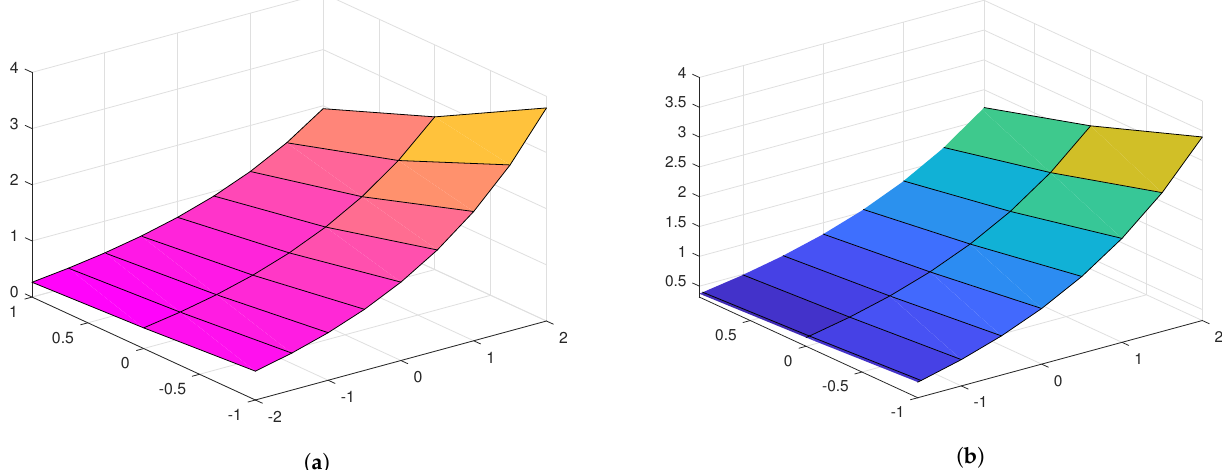
Figure 3. ( a ) Comparison between approximate solution by SDM and VITM plot of example 1 at γ = 0.8. ( b ) Comparison between approximate solution by SDM and VITM plot of example 1 at γ = 0.6.